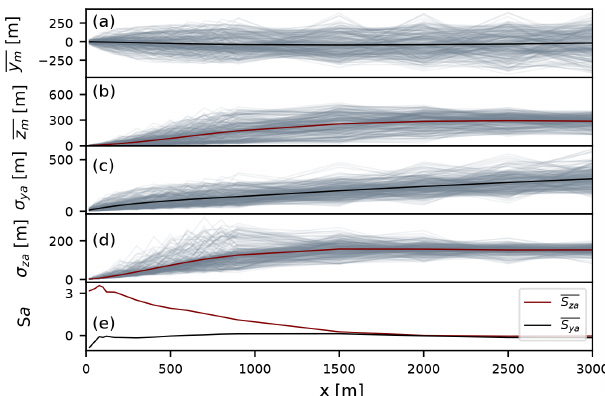
Figure 9. The first three statistical moments of the simulated plume in the absolute coordinate system. The first four panels show posi- tion of the center of mass in y and z directions and the plume width in the y and z directions. All values are shown as a function of downwind distance x . Gray lines denote instantaneous plumes, and mean values are shown as solid black and red lines in y and z di- rections, respectively. The bottom panel shows the skewness of the mean centerline plume position as a function of distance from the source.